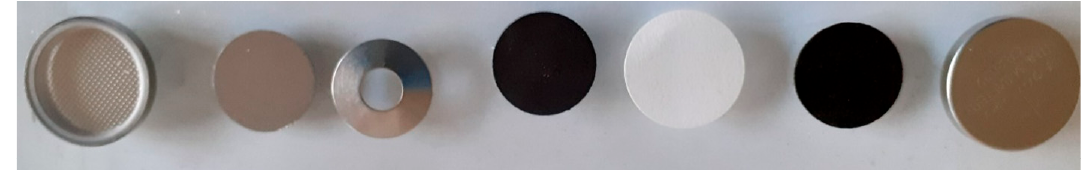
Figure 12. Casing parts of coin cells, including one spring, the electrodes and the separator.